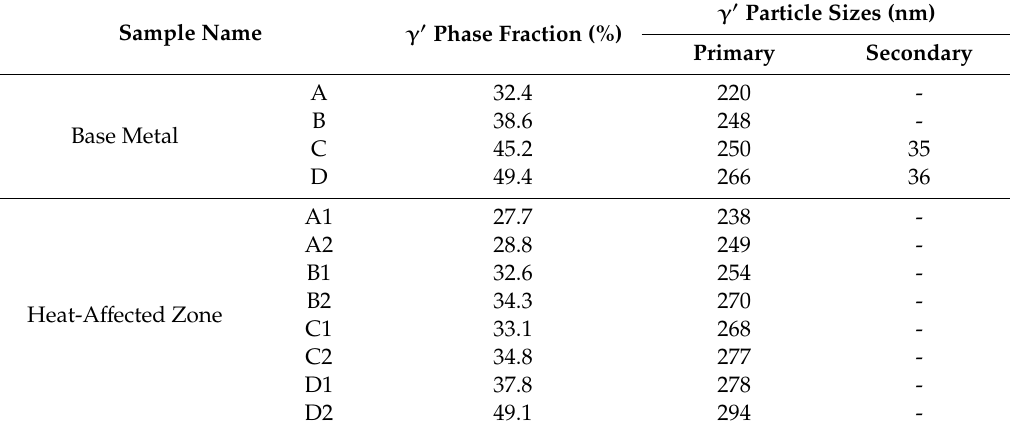
Figure 8. Effect of welding process on γ′ precipitate distribution in heat-affected zone microstructure of welded specimens. Table 4. Comparison of the size and volume fraction of γ ’ precipitates in the BM and the heat-affected zone of welded samples.